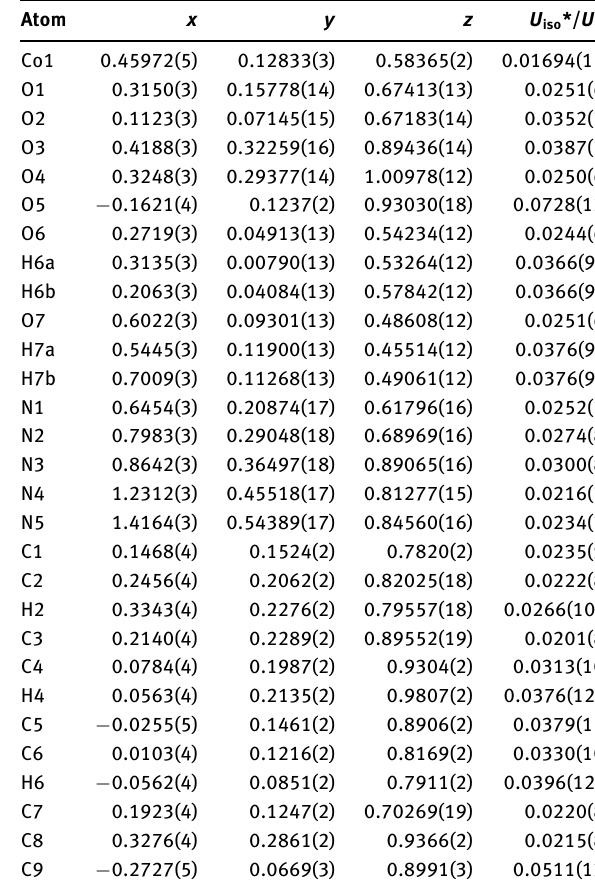
the list of the atoms including atomic coordinates and dis- placement parameters.